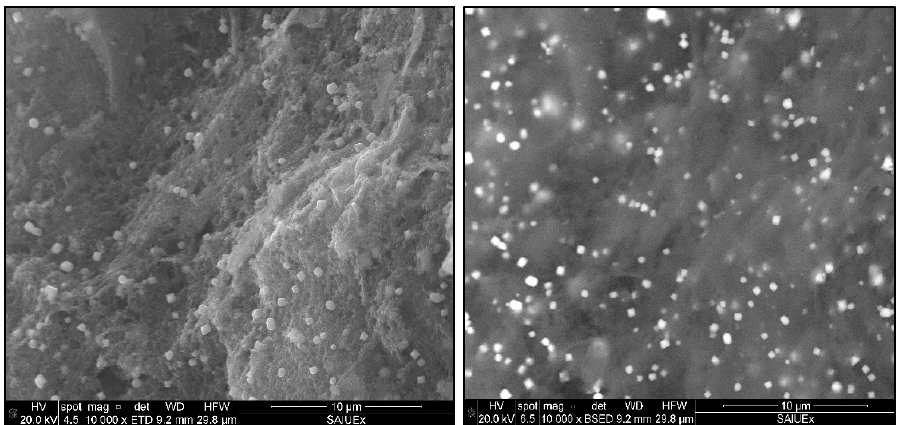
Figure 6 . SEM micrographs of WH-HC-Fe0.25-600 ( left ) and its respective retro-dispersed electron image ( right ).